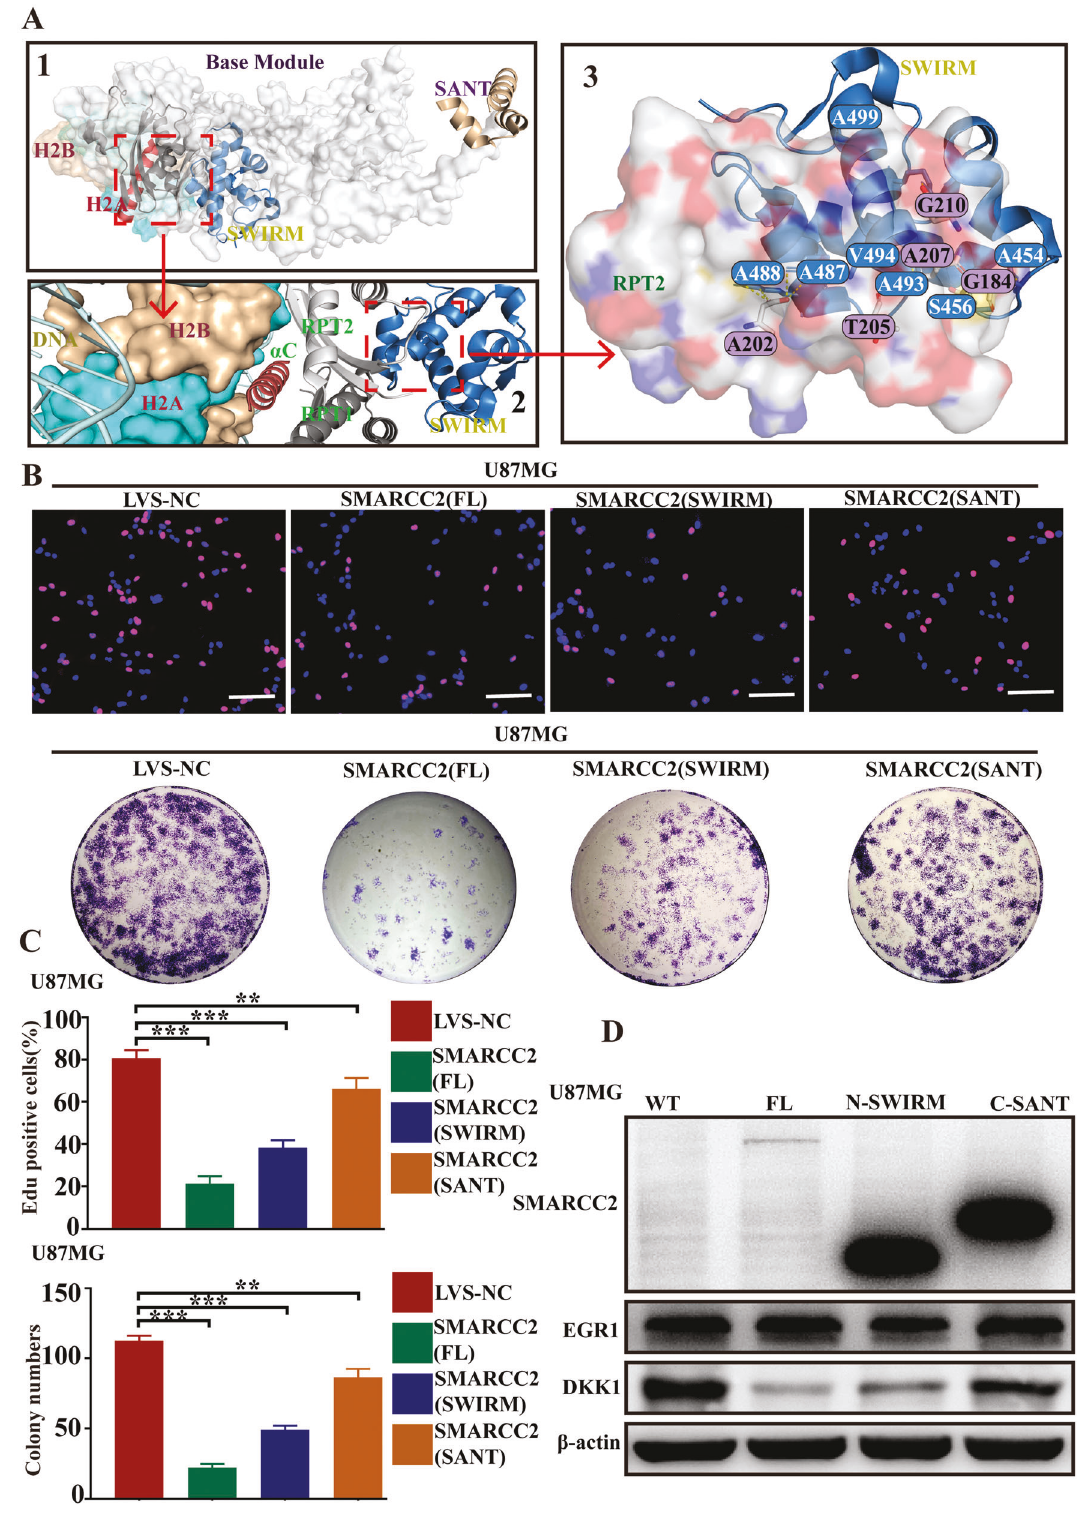
Fig. 5 The functional integrity of SMARCC2 may depend more on the SWIRM domain. A shows the binding model of SWI/SNF and nucleosome (1), and zoom in to show that the SWIRM domain of SMARCC2 binds to the nucleosome via the RPT2 and α C domain of SMARCB1 (2). Further docking analysis revealed the amino acid site where the SWIRM domain and the RPT2 domain bind (3). B Plasmids containing the full-length domain (AA 1 – 1214), N-SWIRM domains (1 – 580 AA), and C-SANT domain (530 – 1214 AA) of SMARCC2 were transfected into U87MG cells.Cells were subsequently tested for proliferative capacity using EDU and colony-forming assay. C , D The mRNA and protein expression levels of SMARCC2, EGR1 and DKK1 were detected by qRT – PCR(C) and western blot ( D ) in U87MG cells transfected with the above plasmids, respectively. Data are expressed as mean ± SEM. ns not signi fi cant, * P < 0.05, ** P < 0.01, *** P < 0.001.